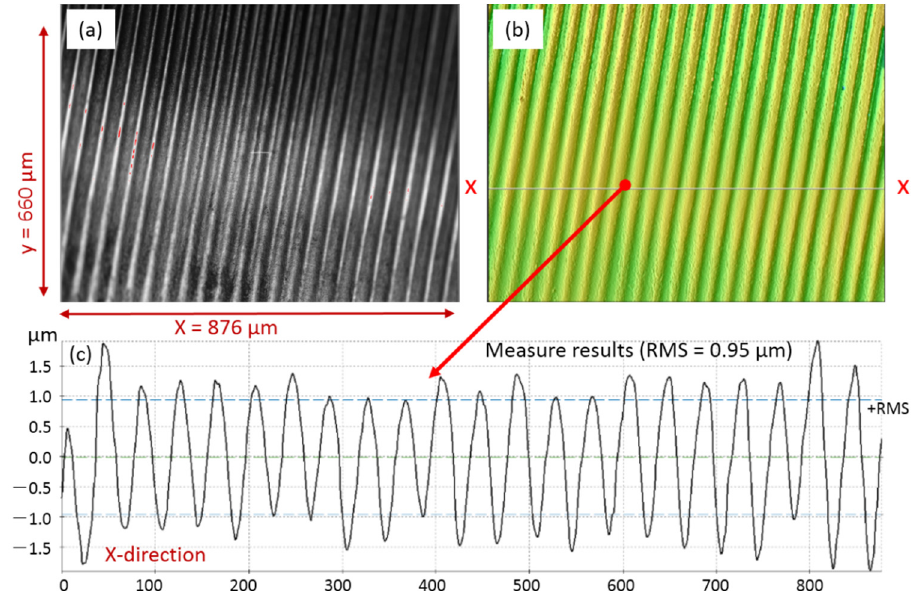
Figure 11. The side surface properties for the femtosecond pulse laser cutting kerf: ( a ) the side surface imaging formation of the cutting kerf wall; ( b ) the measured formation of the flank wall; and ( c ) the numerical value result for the x-x section.